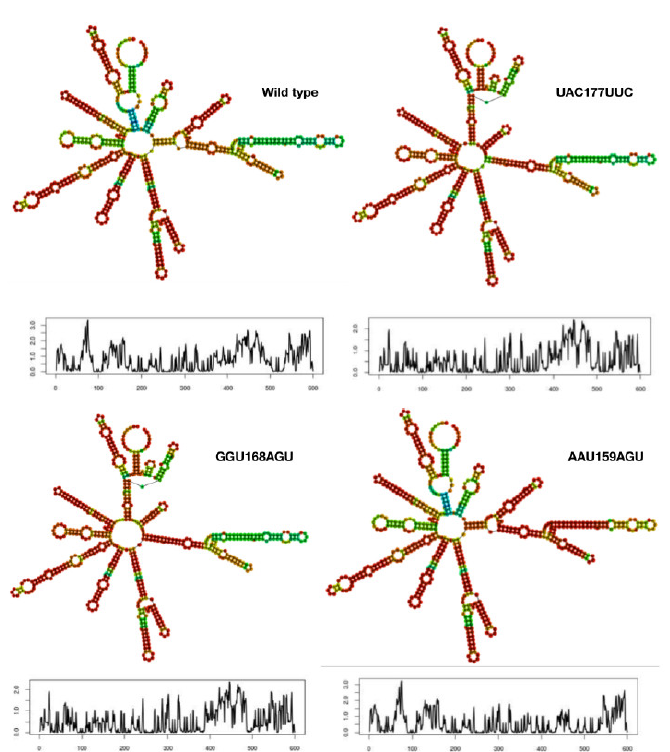
Figure 3. Secondary structure and stability of mRNA. The secondary structure of three mutants are compared to the wild type along with their entropic profiles obtained from the RNAfold server. The entropic profiles were plotted with position of the base taken on x -axis vs. entropy on the y -axis. Evidently all four show different profiles for their secondary structures as well as their entropic distributions.